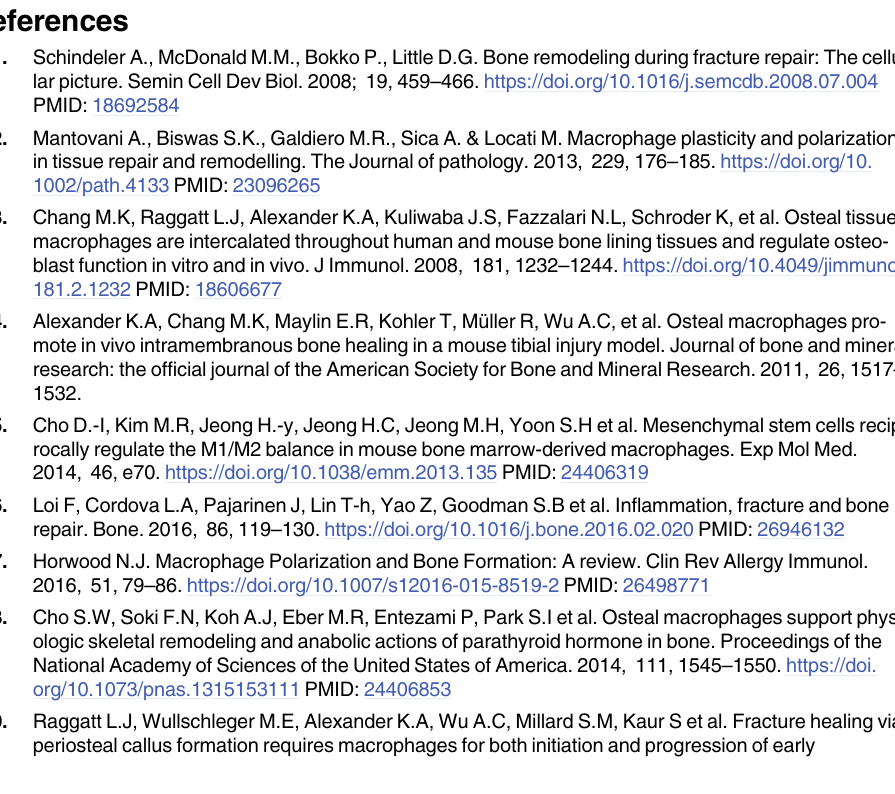
(red) types of cellular interactions. e Temporal plots and corresponding goodness of fit metrics (AIC and R2s) across all populations, obtained through J 1